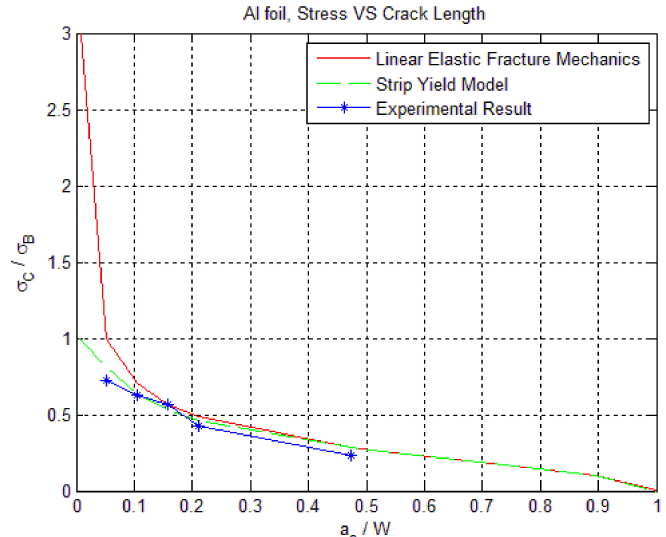
Figure 17. Fracture toughness